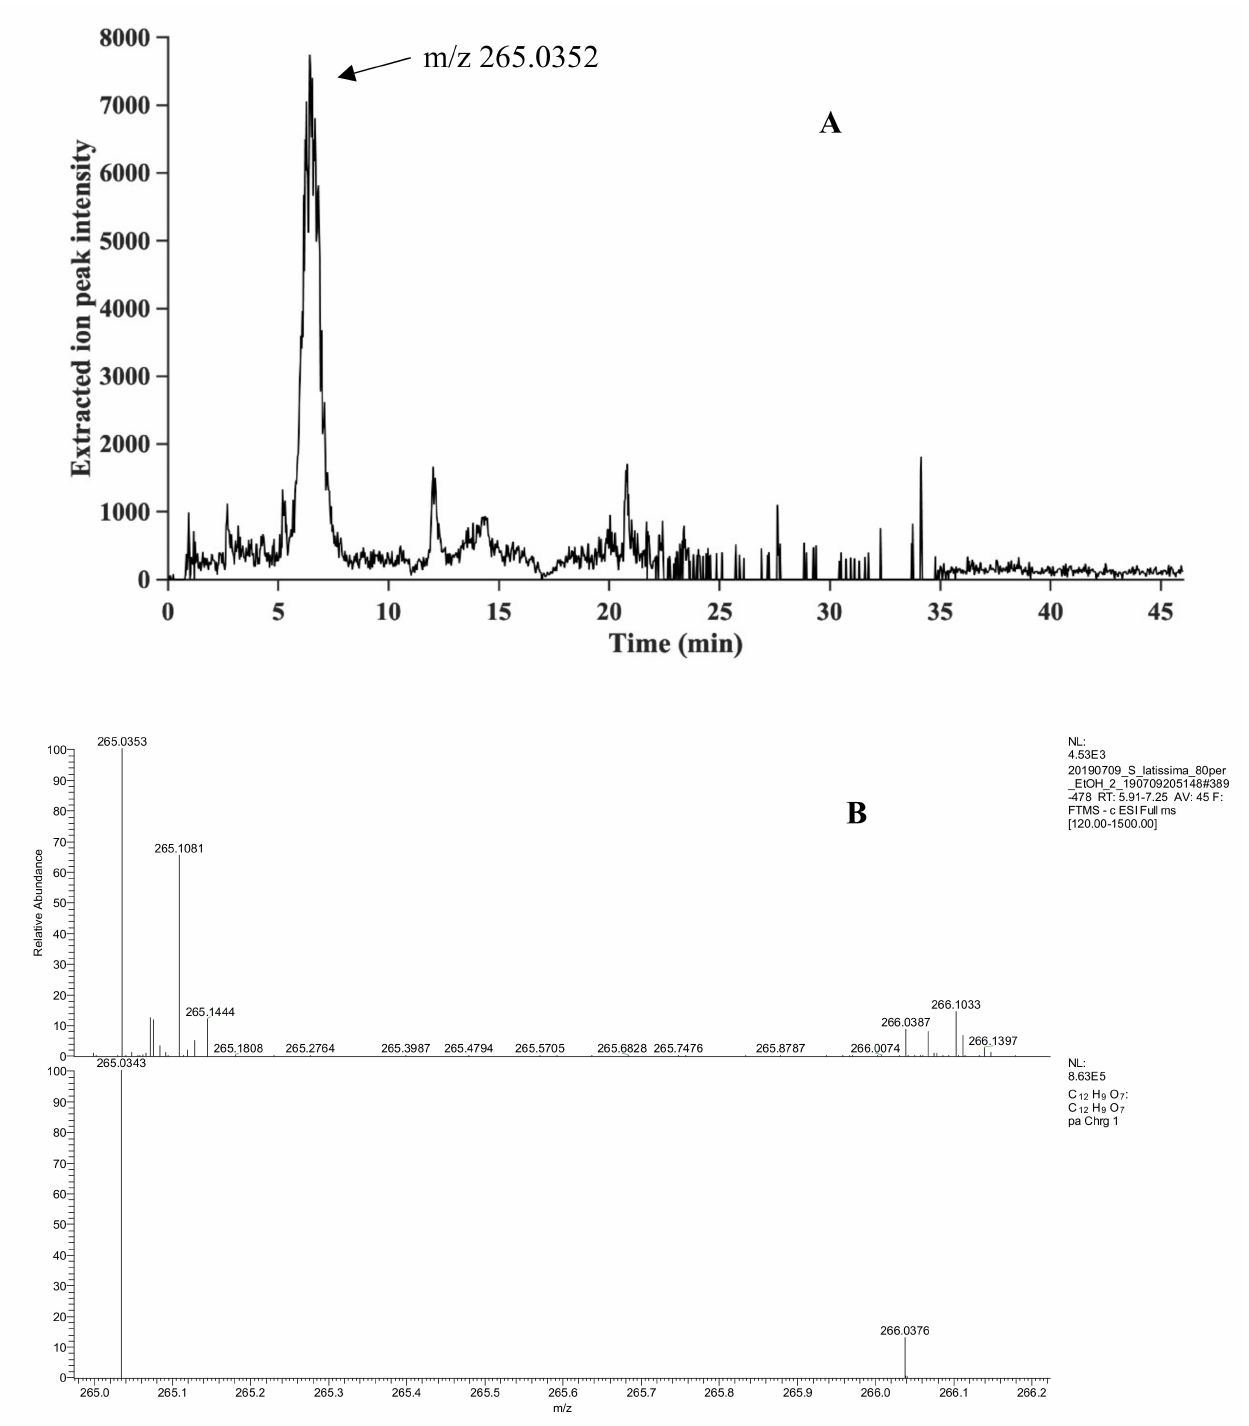
Figure 4. ( A ) Extracted ion-chromatogram of m / z 265.0352 found in S. latissima . ( B ) Comparison of detected ( top ) and calculated ( bottom ) isotopes for m / z 265.0352 found in S.